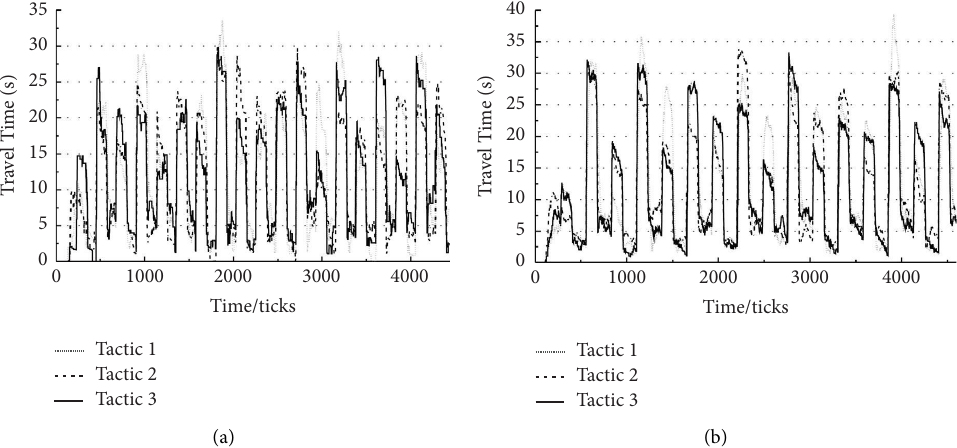
Figure 10: Comparison chart of travel time with diferent control tactics: (a) travel time during of-peak hours and (b) travel time during peak